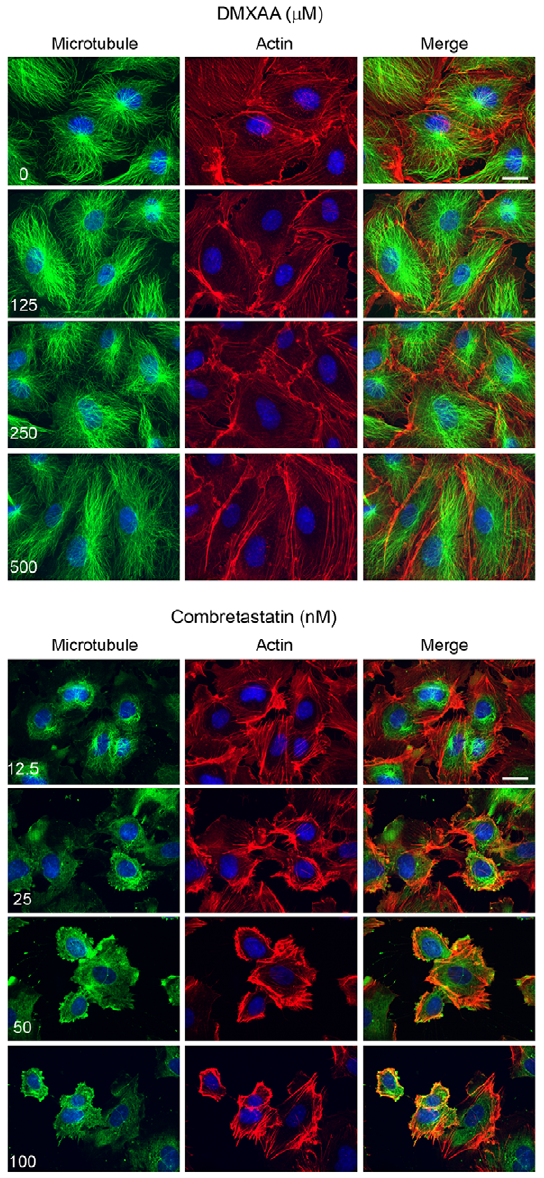
Figure 2. DMXAA did not disturb microtubule or actin structure. Cells were treated with serial dilutions of DMXAA for 30 min and CA4 for 10 min. Immuno-staining was performed using anti-DM1alpha and rhodamine-phalloidine to visualize microtubule and actin respectively. Microtubules are shown in green and actin in red. Nuclei were stained using DAPI (blue). The white bar indicated 20 m m.